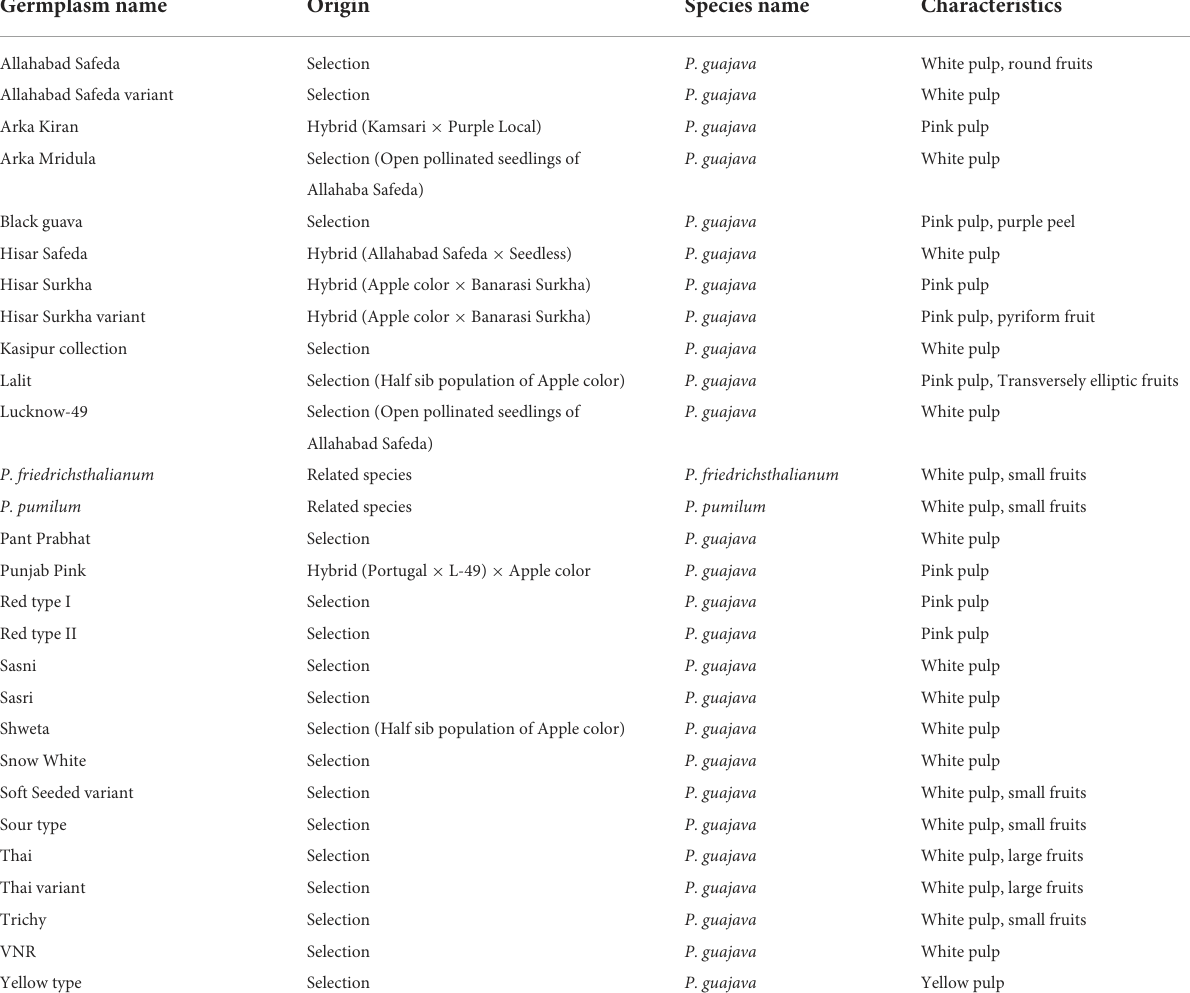
TABLE 1 Details of 28 guava ( Psidium guajava L.)